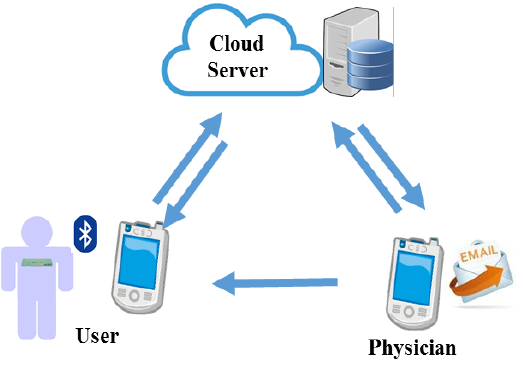
Figure 1. Mobile healthcare system.